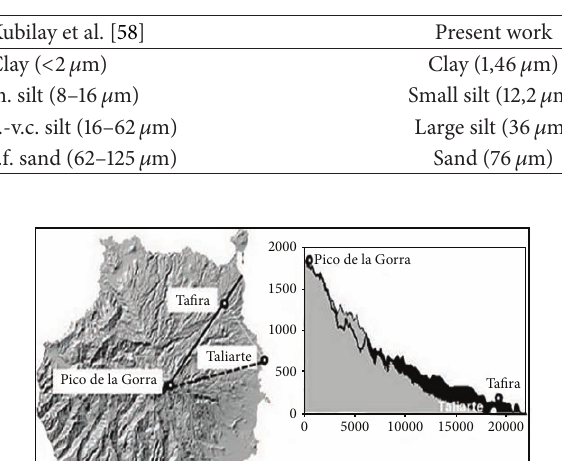
Table 3: Comparison between textural analyses of Aeolian dust sample collected in Gran Canaria and model output related to fraction of dry deposition of four grain sizes.